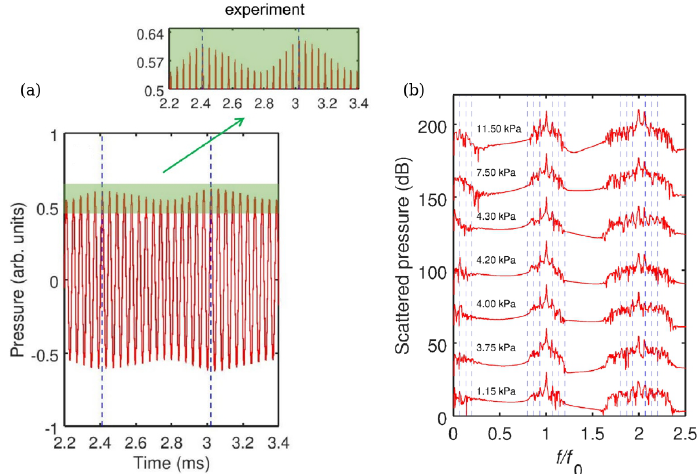
Figure 12. ( a ) Measured acoustic response of a bubble. The time between the vertical dashed lines is ∆ T = 1/ f nat ≈ 0.6ms, where f nat is the natural frequency of the bubble oscillations (see [184] for details). The insets show a closeup of the waveforms and demonstrate the amplitude modulation. ( b ) Experimental AFC spectra obtained using gas bubbles in water insonated with an f 0 = 24.6kHz sinusoidal signal of increasing pressure amplitude α =1.15, 3.75, 4, 4.2, 4.3, 7.5 and 11.5 kPa. The scat- tered pressure values (in dB) are given along the vertical axis with a vertical offset of 30dB between the spectra. Reproduced from [184] published by Springer Nature under the terms of the Creative Commons CC BY